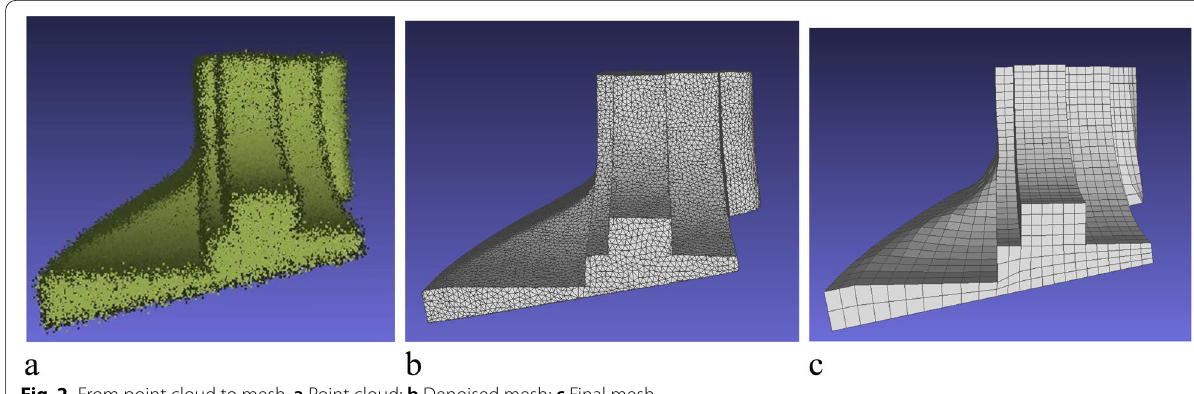
Fig. 2 From point cloud to mesh. a Point cloud; b Denoised mesh; c Final mesh